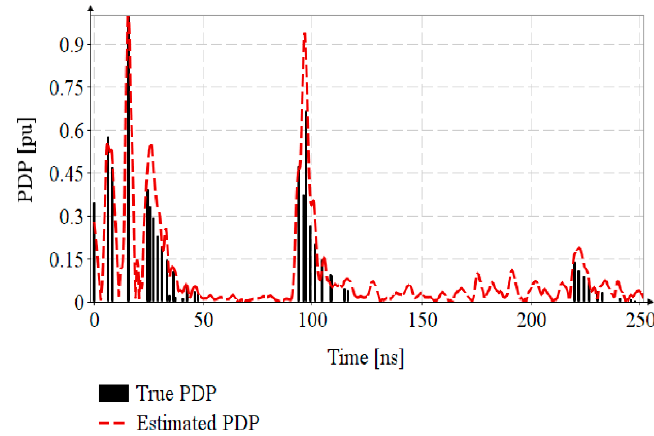
Figure 5. CIR estimation for channel with multipath propagation.